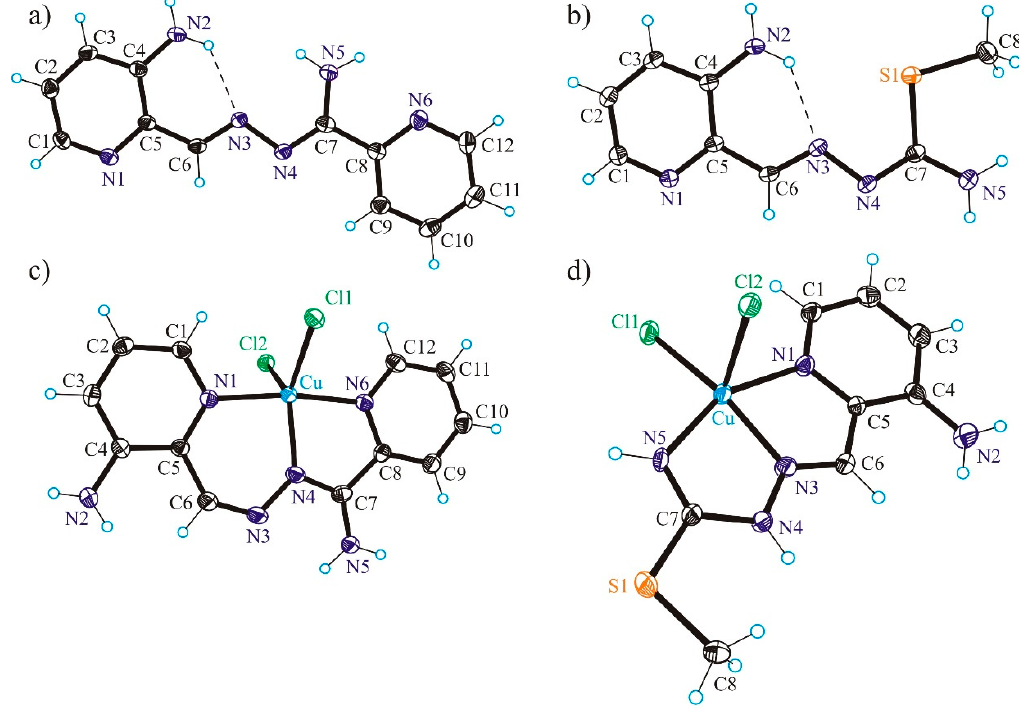
Figure 1. ORTEP views of ( a ) HL 1 , ( b ) HL 2 , ( c ) [Cu(HL 1 )Cl 2 ] ( 1 ) and ( d ) [Cu(HL 2 )Cl 2 ] ( 2 ). Selected bond distances (Å) and bond / torsion angles (deg) in HL 1 : C4–N2 1.350(3), C4–C5 1.422(3), C5–C6 1.455(2),